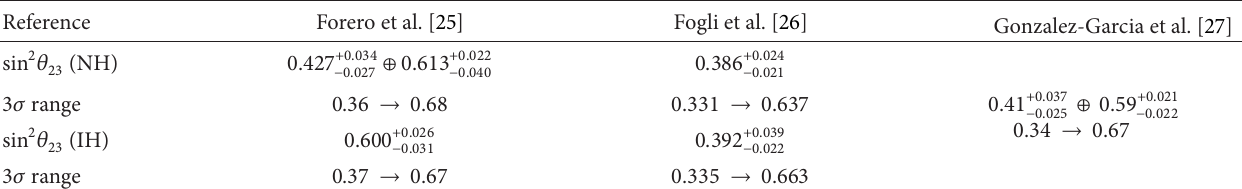
Table 1: 1𝜎 bounds on sin 2 𝜃 23 from the global fits performed in [25–27]. The numbers cited from [27] have been obtained by keeping the reactor fluxes free in the fit and also including the short-baseline reactor data with 𝐿 ≲ 100 m, with the mass hierarchy marginalized. This table has been taken from